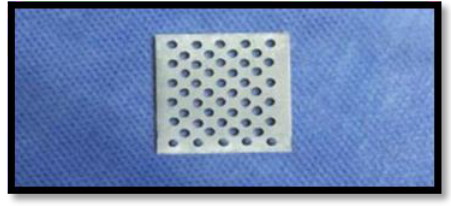
Figure 4: The aluminum plate for standardization of CO